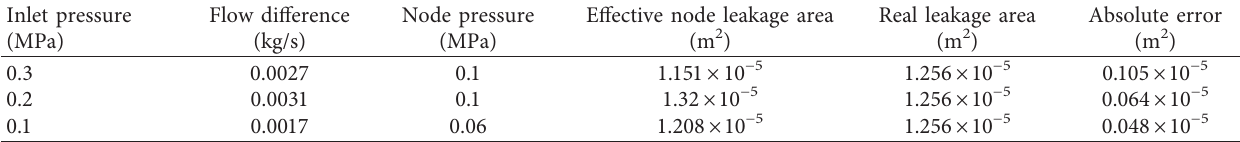
Table 2: The second test of X 5 node leakage parameters under different pressures.